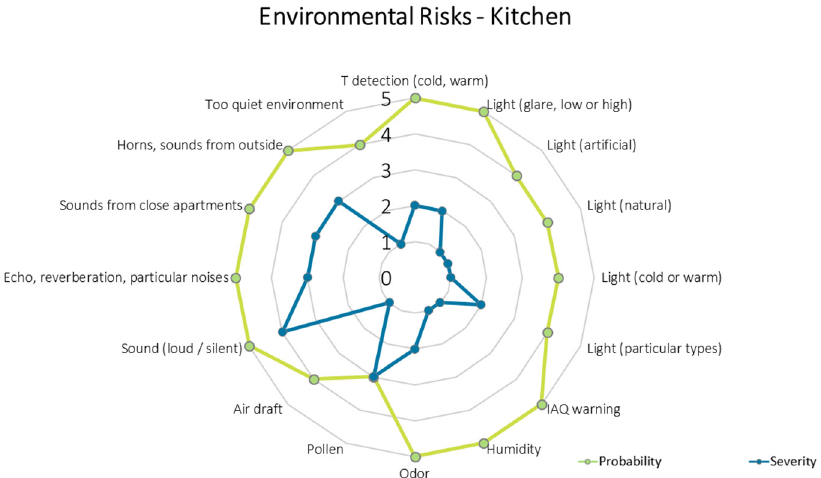
Figure 4. Probability and severity in the kitchen of a typical living environment: Environmental Risks.